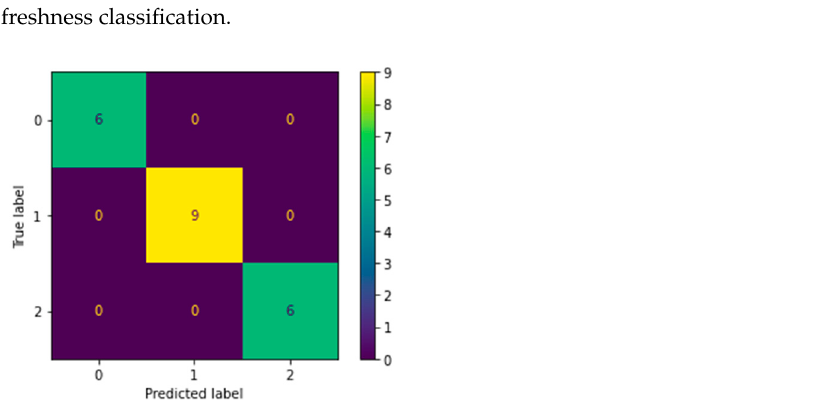
Figure 14. Confusion matrix of salmon sample prediction performed by Ensemble.